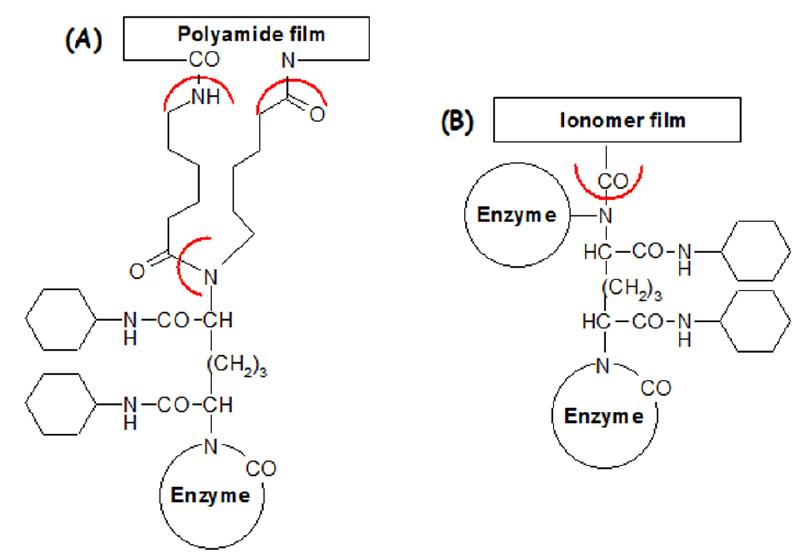
Figure 3. The scheme of linkage between enzyme and polyamide film (A) and ionomer film (B) with indication of hypothetical cleavage (dashed curve) of enzyme from